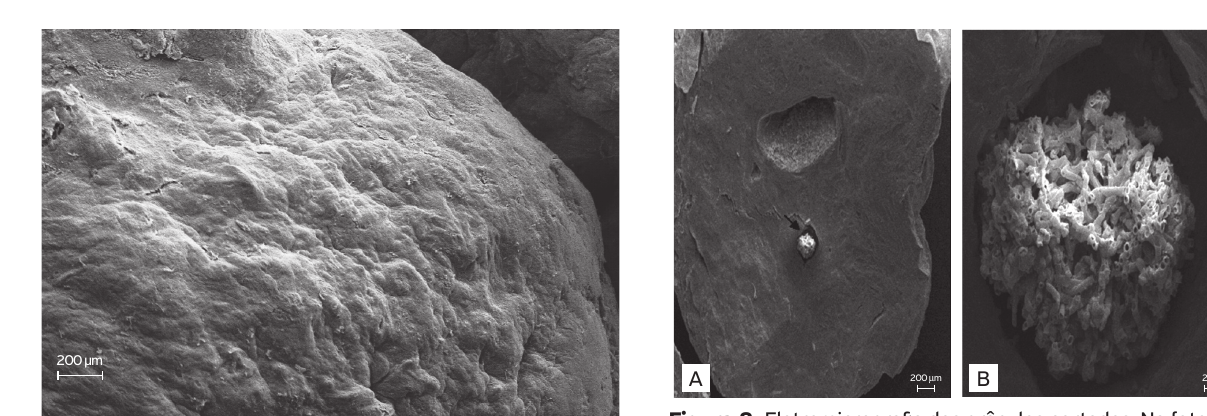
Figura 8. Eletromicrografia dos grânulos cortados. Na foto (A), a seta indica um emaranhado de hifas no centro do grânulo. Na foto (B), aproximação do emaranhado de hifas da